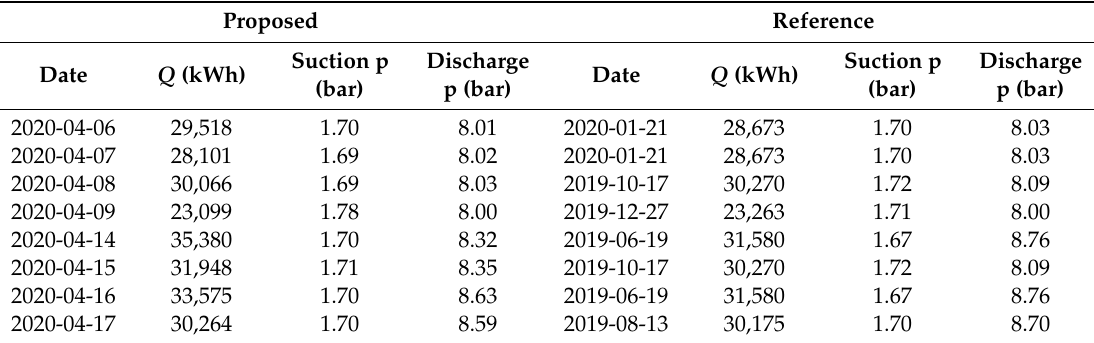
Table 4. Comparison between the variables of validation days and reference days.